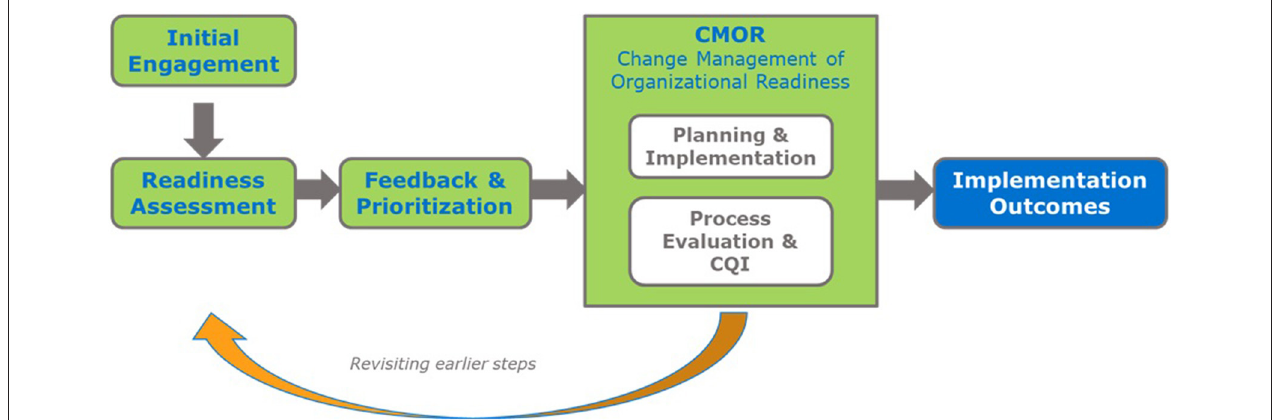
FIGURE 2 | The readiness building system [RBS; (15, 16)].